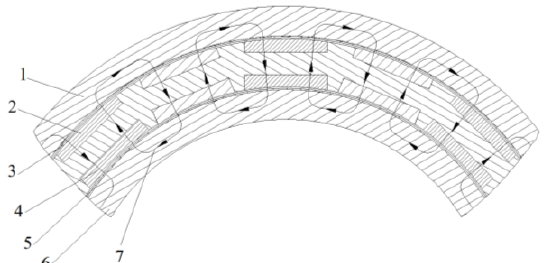
Figure 4. Local schematic diagram of permanent magnet braking device with copper coating. 1 — outer rotor drum; 2 — outer permanent magnet; 3 — outer air gap; 4 — inner permanent magnet; 5 — inner air gap; 6 — inner rotor drum; 7 — magnetization direction.